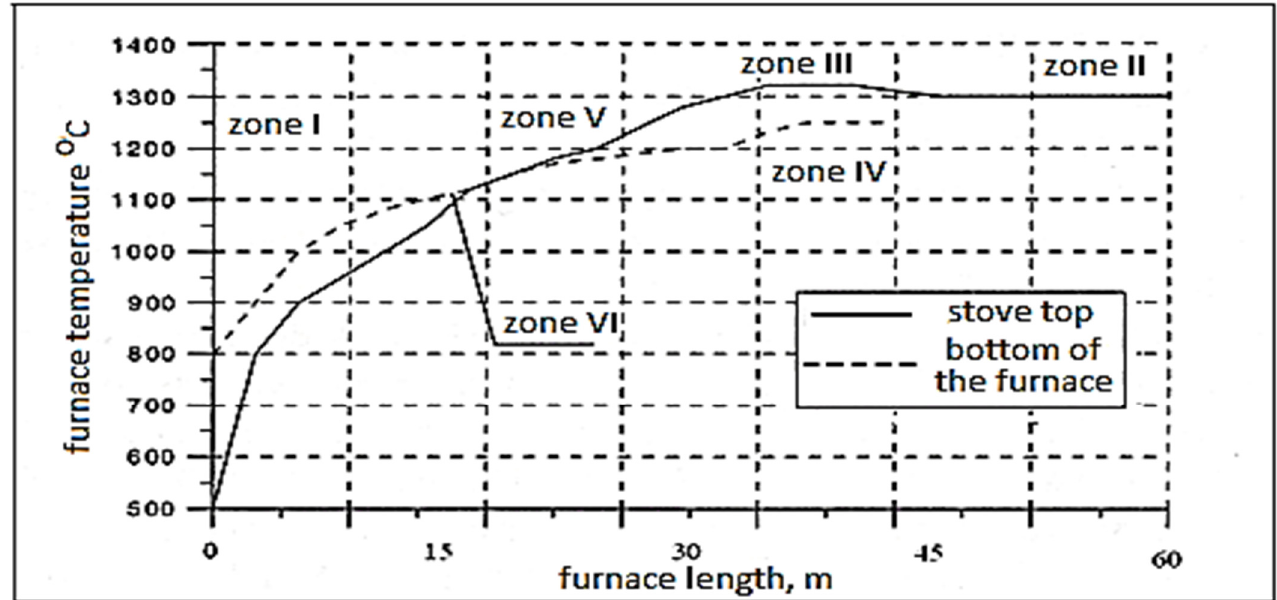
Figure 7. Walk-in furnace substitute heat transfer coefficients. Source: own study.